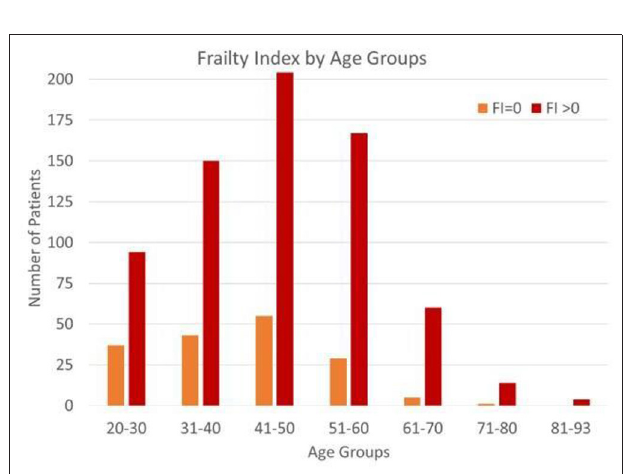
FIGURE 3 | Frailty index by age group. Proportion of FI = 0 and FI greater than zero. The proportion of patients with a non-zero Frailty Index increased significantly ( p < 0.001) from the younger to other age groups (20–45 vs. 46–93).